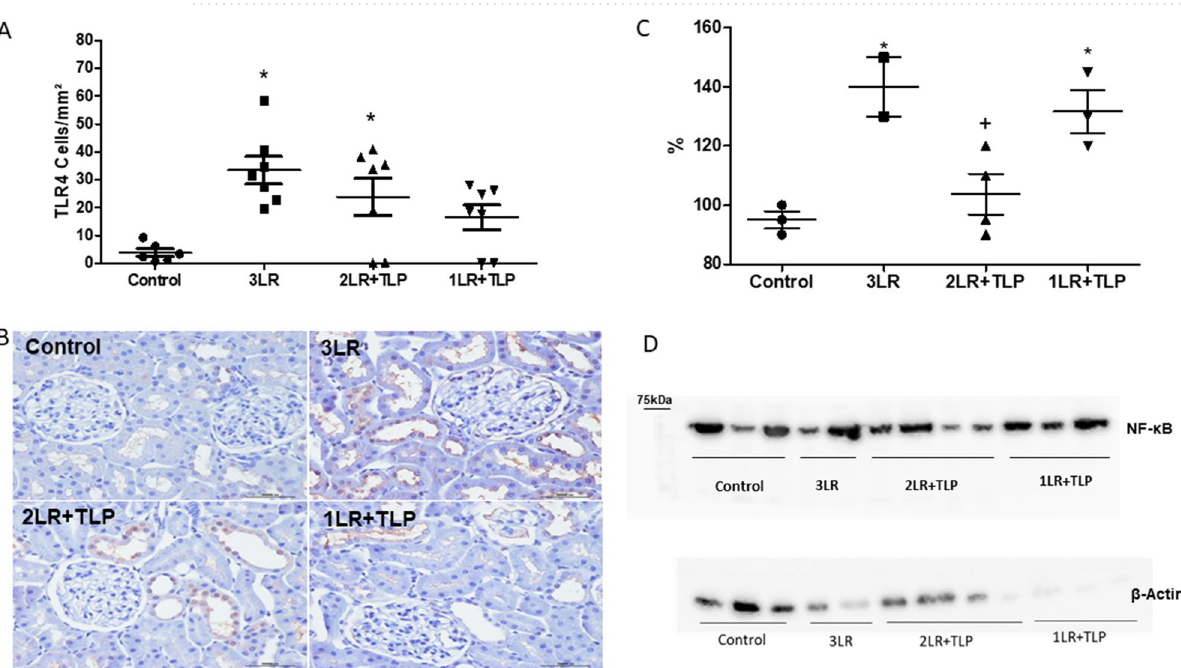
Figure 5. Immunohistochemical analysis of Toll-like receptor 4 (TLR4) expression in rat kidney tissue. (A) Bar graph of TLR4 expression. Immunostaining (brown, in B) for TLR4+ cells in kidney cortex samples from control, 3LR, 2LR + TLP, and 1LR + TLP group rats. Magnification, × 400. Densitometric analysis (C) and immunoblotting (D) of nuclear factor kappa B (NF-κB) expression in the renal tissue at 24 h after hemorrhagic shock induction (Supplementary Fig. 2). * P < 0.05 vs. control; + P < 0.05 vs. 3LR and 1LR + TLP. Control, no intervention; 3LR, induction of hemorrhagic shock, followed by infusion of lactated Ringer’s at 3 times the volume of the blood withdrawn; 2LR + TLP, induction of hemorrhagic shock, followed by infusion of lactated Ringer’s at 2 times the volume of the blood withdrawn, together with intravenous injection of terlipressin at 10 µg/100 g body weight; 1LR + TLP, induction of hemorrhagic shock, followed by infusion of lactated Ringer’s at a volume equal to that of the blood withdrawn, together with intravenous injection of terlipressin at 10 µg/100 g body